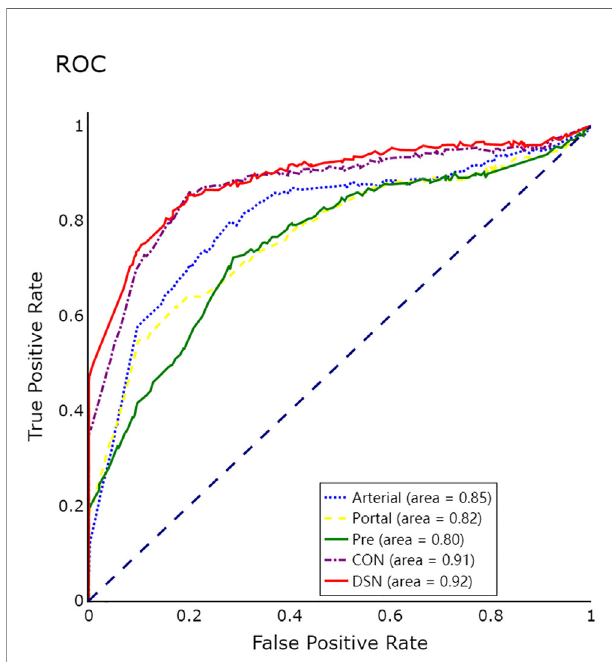
FIGURE 3 | ROC curves of 3D convolutional neural networks (CNN) for microvascular invasion (MVI) prediction in single phases and multiple phases.